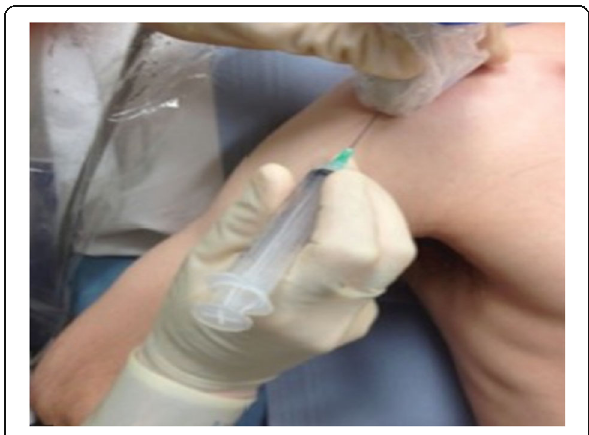
Fig. 2 Patient positioning during ultrasound-guided